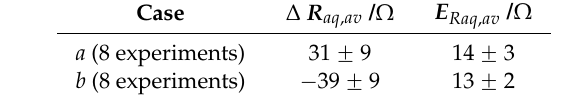
Table 4. Case dependent average of tap water resistance parameter R aq fitted according to the model presented in Figure 1, including standard error. The quality of the fits can be appreciated from the average fitting error of this parameter, E Raq , av and its associated standard error. Case ∆ R aq , av / Ω E Raq , av / Ω a (8 experiments) 31 ˘ 9 14 ˘ 3 ´ 39 ˘ 9 13 ˘